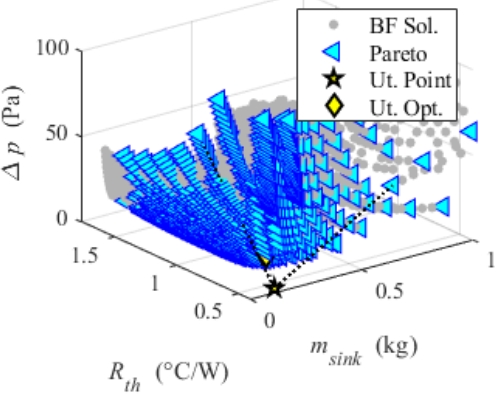
Figure 2. Optimized space of solutions for the three objective functions here investigated.